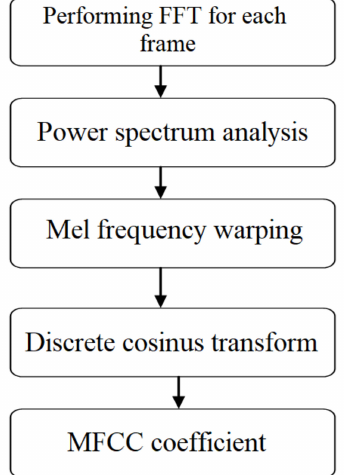
Figure 4. UAV-associated MFCC coe ffi cients extraction